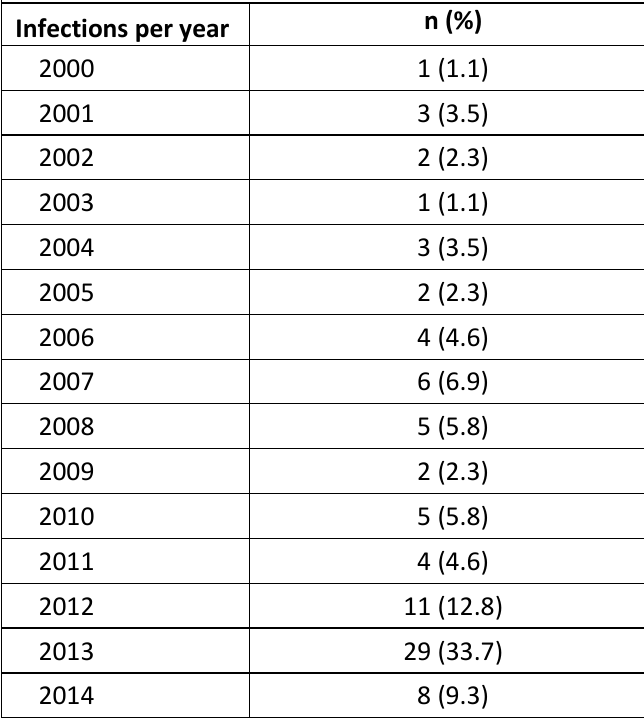
Table S1: Patients with invasive beta-haemolytic streptococcal infections per